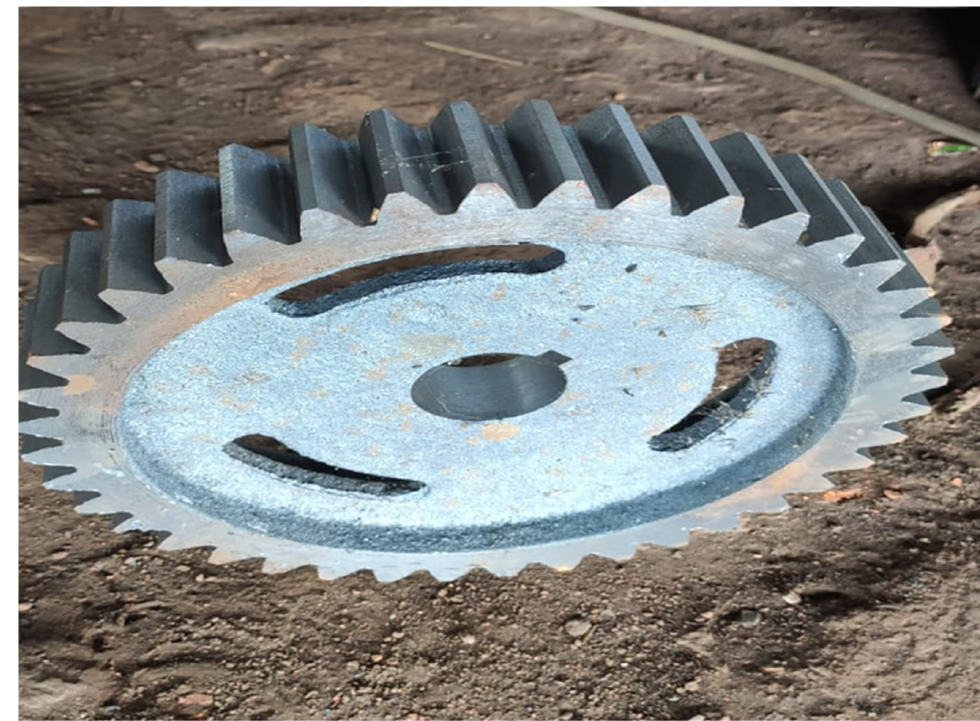
Figure 3. Power loom change gear. Table 1. The inside diameter (in mm) of power loom change gear in fuzzy environment.